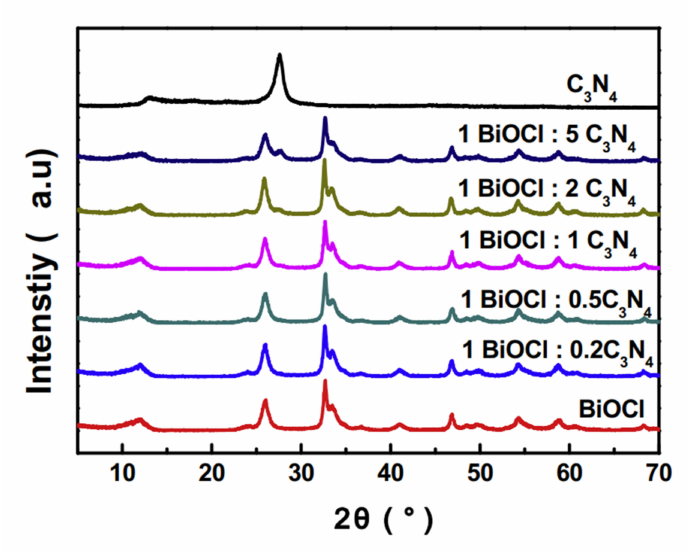
Figure 3. XRD patterns of BiOCl, C 3 N 4 , and g-C 3 N 4 /BiOCl heterojunction in different compositions. Reproduced with permission from Wang XJ et al, Chemical Engineering Journal; published by Elsevier BV,